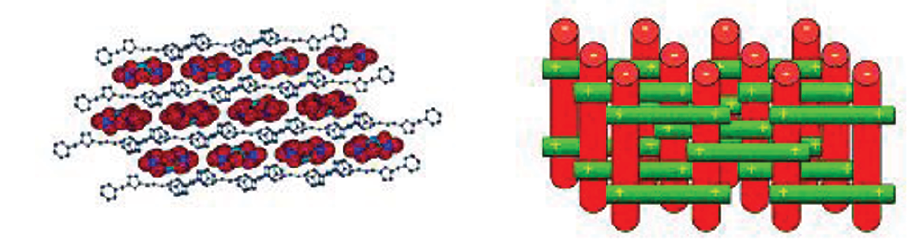
Figure 3. The {[Cu(NO ) ]···O1···O–NO -} motifs (spacefill representation, left) are located in channels along the b axis, whereas the motif formed 3 2 2 n by the stacking of the carbene cations generate a two dimensional layer-like motif (capped sticks representation, left). The overall su- pramolecular arrangement may be represented as anionic channels (right side in red) where the cations are closely stacked (right side in green). Hydrogen bonds exist between the nitrate anions and hydrogen atoms of the carbene di-cations to form a three-dimensional motif in the solid